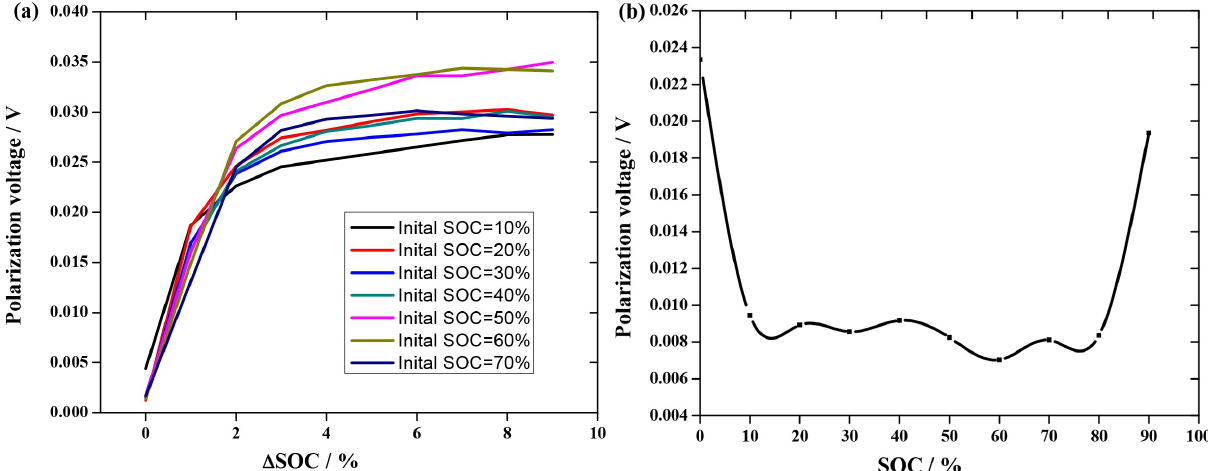
vs. initial SOC (the battery was charged at the rate of